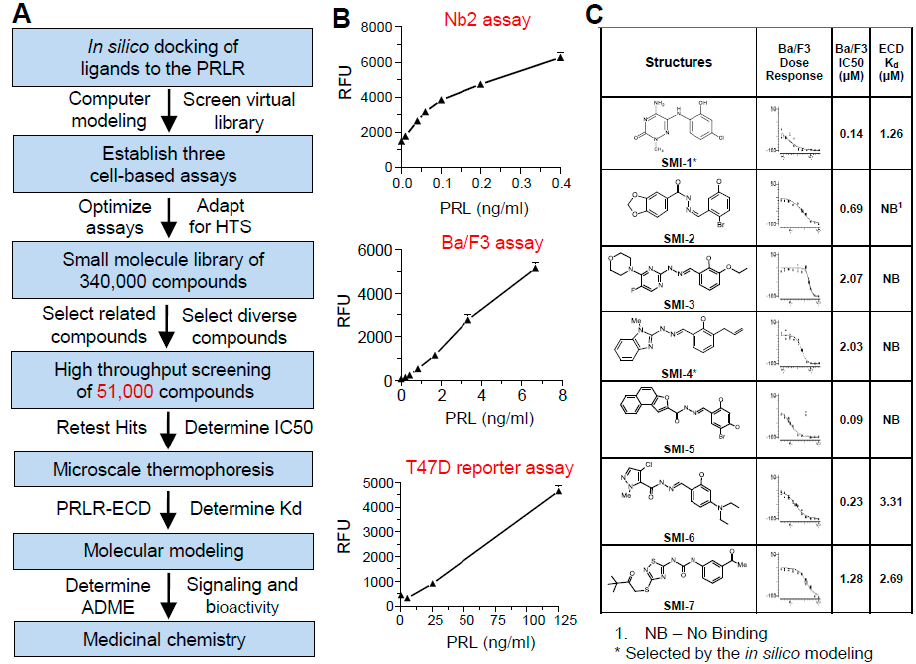
Figure 1. Strategy for high throughput screening (HTS) and molecular characterization of small molecule inhibitors (SMIs) of prolactin (PRL) signaling. ( A ) Steps of selecting 51,000 compounds, HTS screening, and validation. ( B ) Dose–response curves of 3 cell-based assays used sequentially. Bars are means ± SEM ( n = 3–5). Cells in each assay were incubated with PRL alone, compound alone, or compound + PRL. RFU = relative fluorescent units. ( C ) Characteristics of the 7 SMIs with the best IC50 values in the Ba/F3 assay. Shown are the chemical structures, dose–response inhibition curves against PRL and calculated IC50s in the Ba/F3, and dissociation constants (Kd) to the extracellular domain (ECD) of the PRLR in the microscale thermophoresis (MST) assay.